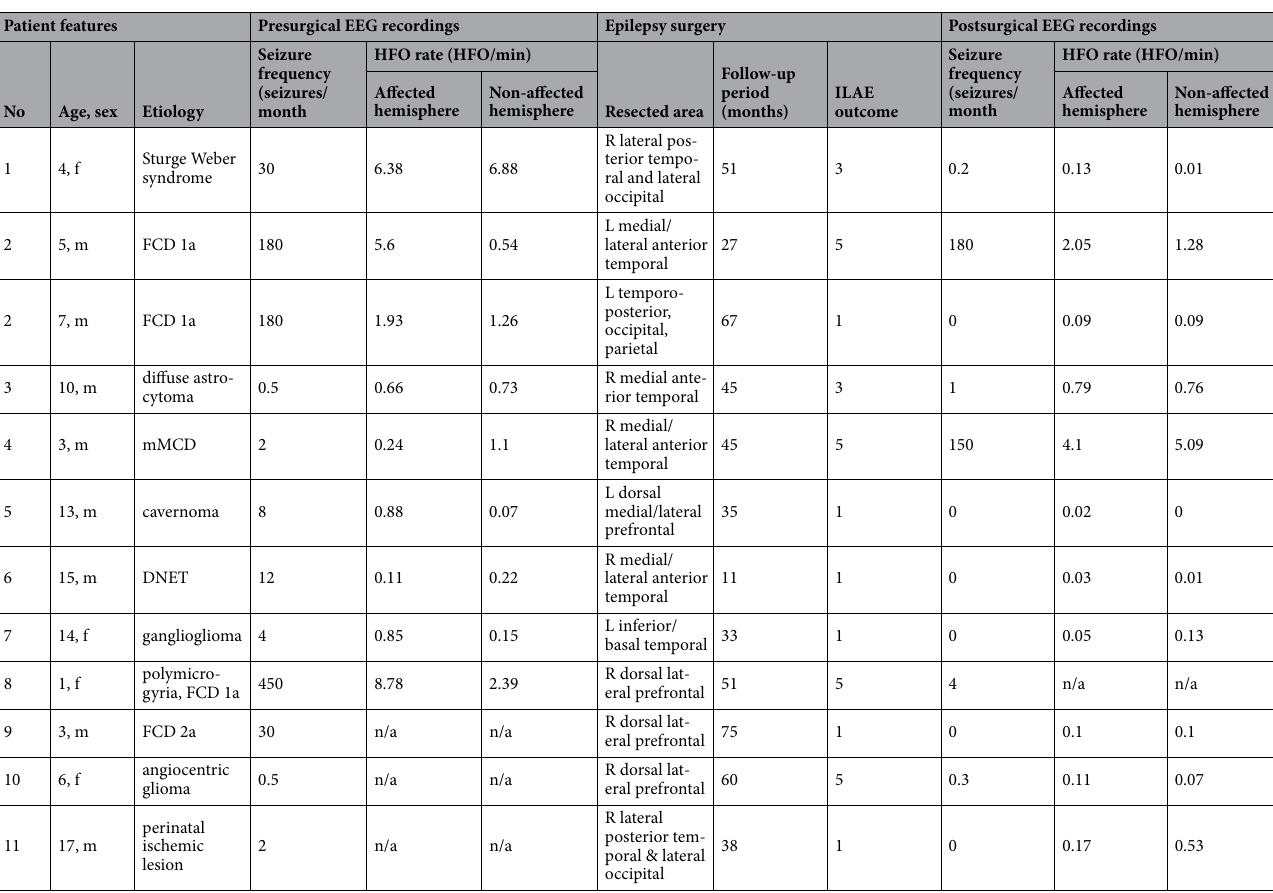
Table 2. Patient characteristics at the pre- and postsurgical EEG recordings. Seizure etiology, pre- and postsurgical seizure frequency, lateralization and localization of surgical resection, postsurgical follow-up duration, final seizure outcome according to the ILAE classification, HFO recording channels and rates in the pre- and postsurgical EEG. m: male; f: female; L: left; R: right; FCD: focal cortical dysplasia; mMCD: mild malformation of cortical development; DNET: Dysembryoplastic neuroepithelial tumor; ECoG: electrocorticography; HFO: high frequency